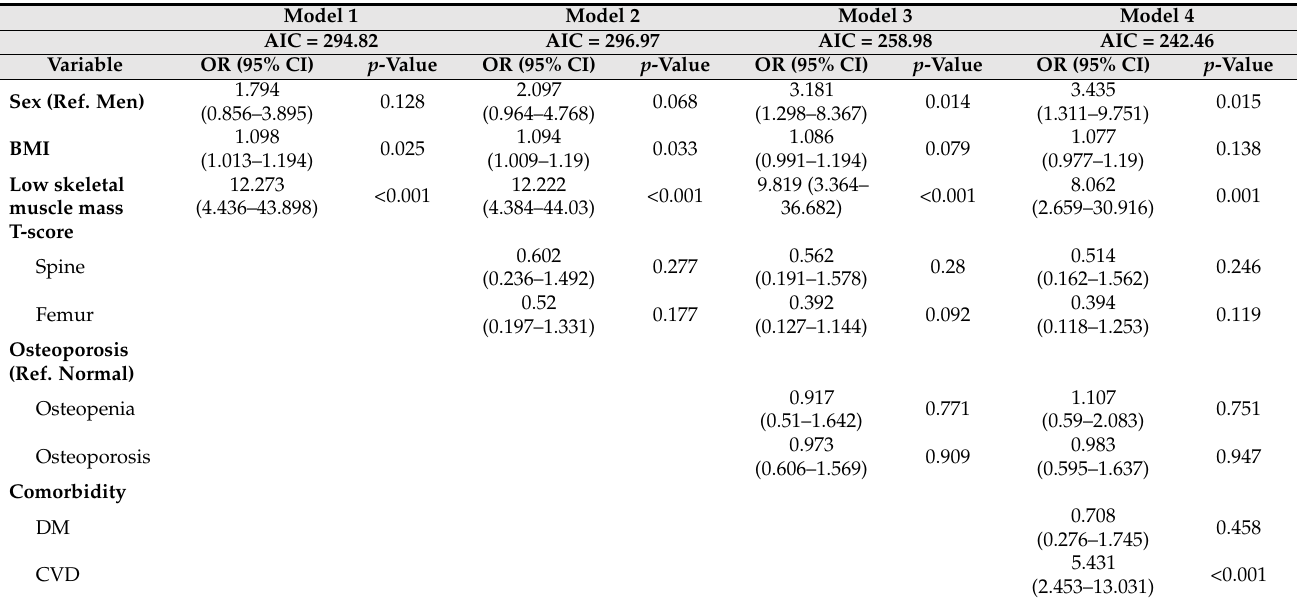
Table 4. Multivariate logistic regression analysis of factors associated with